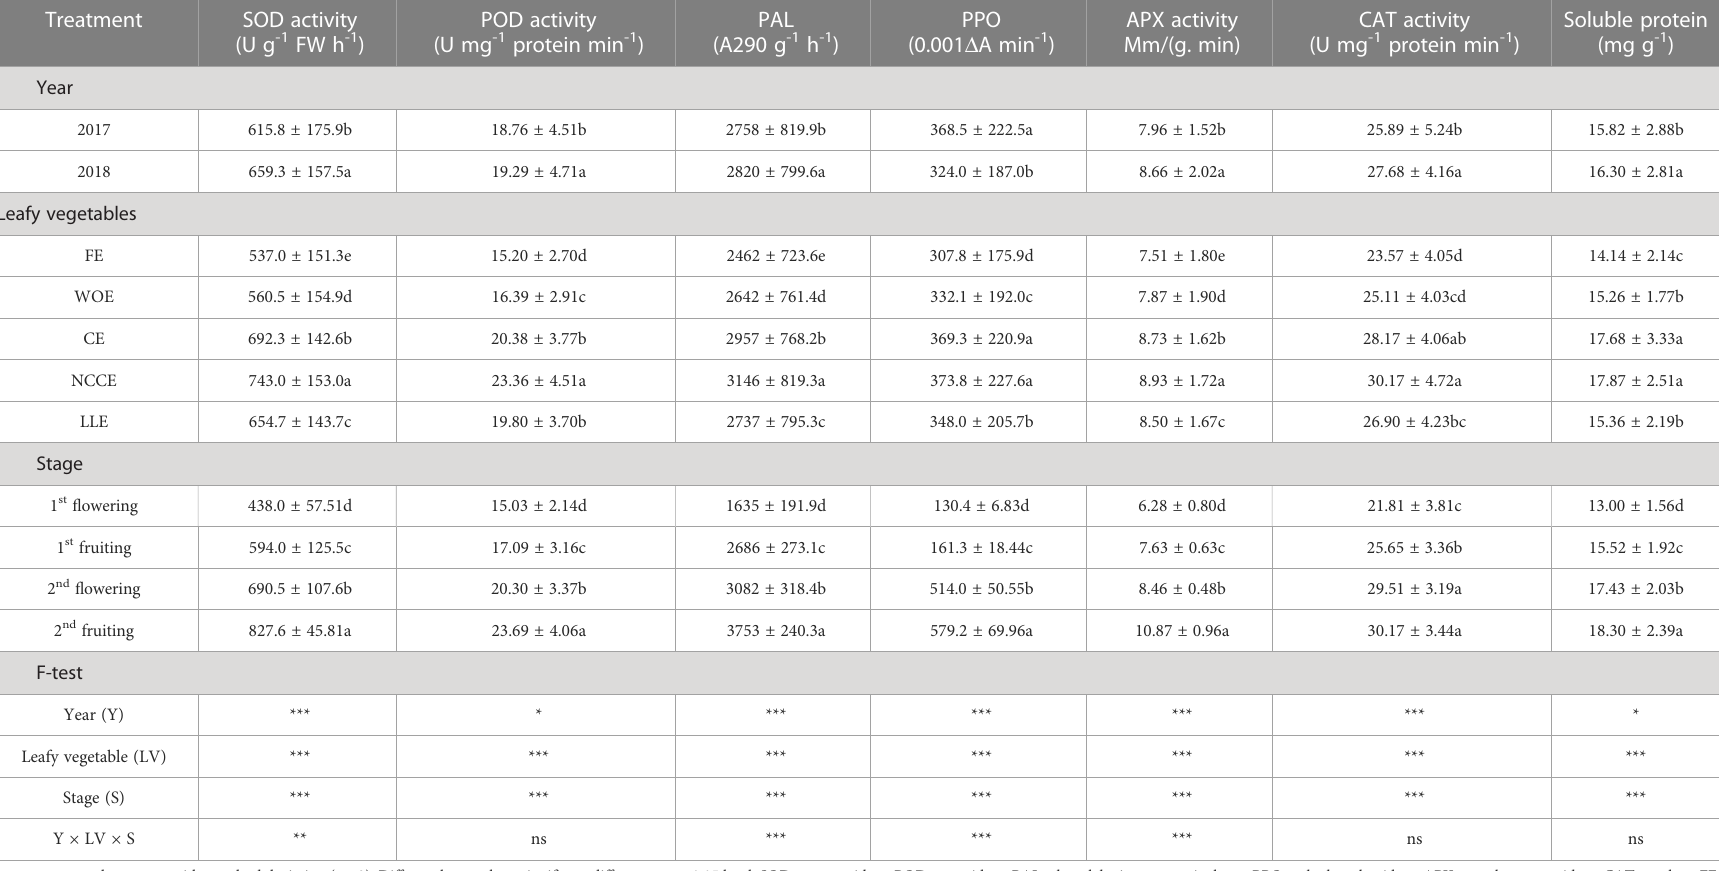
TABLE 4 Effect of different leafy vegetable rotation systems on the antioxidant system and soluble protein of eggplant at different growth stages during the year 2017 and